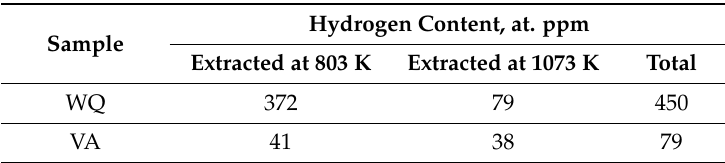
Table 1. Hydrogen extracted from differently treated